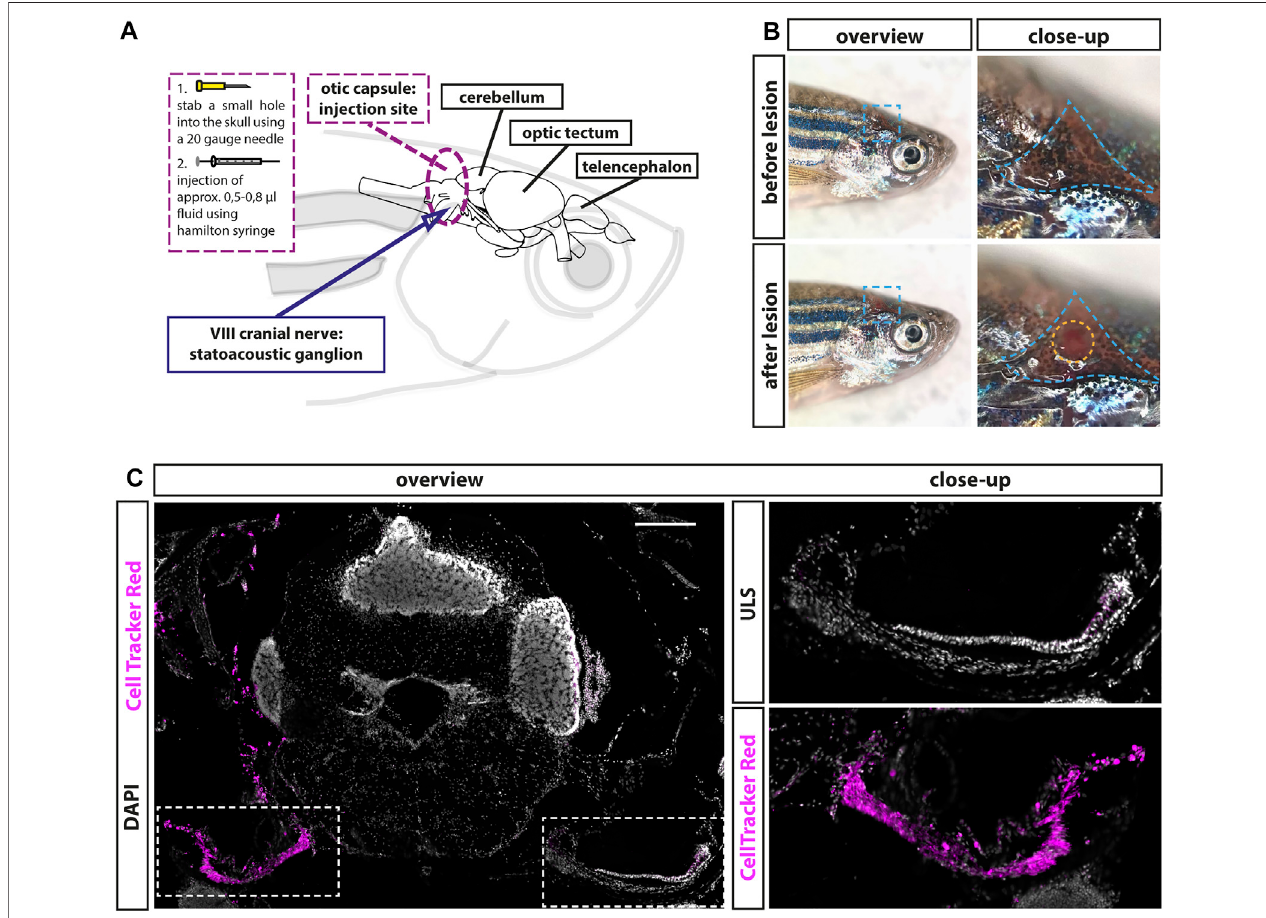
FIGURE1| Establishmentofalesionparadigmoftheadultzebra fi shstatoacousticganglion(SAG). (A) Schemeofthezebra fi shheadwiththebraininsideshowing the injection position in relation tothe brain and the SAG. A 20-gauge needle was used toopen the skull before inserting aHamilton syringe vertically approximately 1.2- to1.5-mm deep intotheskullalongthedorsal – ventralaxis.Subsequently, theHamilton syringewaseitherremoved(sham-treated control)or 5 – 8 µlofeither0.9% NaCl or100 µMouabainsolutionwasslowlyinjected. (B) Overviewofliveadultzebra fi shbeforeandafterinjection.Close-upsofthebluedottedboxesshowtheinjection side within the triangular bone (dotted blue line). Lower close-up shows the hole after injection (dotted yellow circle). (C) Immunohistochemistry of a transverse cross sectionattheheightoftheanteriorSAGfollowingCellTrackerRedinjectionintotherightinnerearshowedastronglabelingoftheSAGontheinjectedsidebutnolabeling of the unlesioned side (ULS). Scale bar: 200